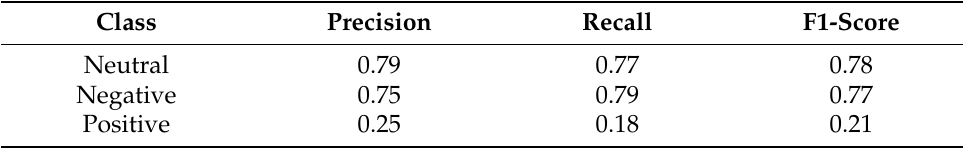
Table A8. Multilayer Perceptron